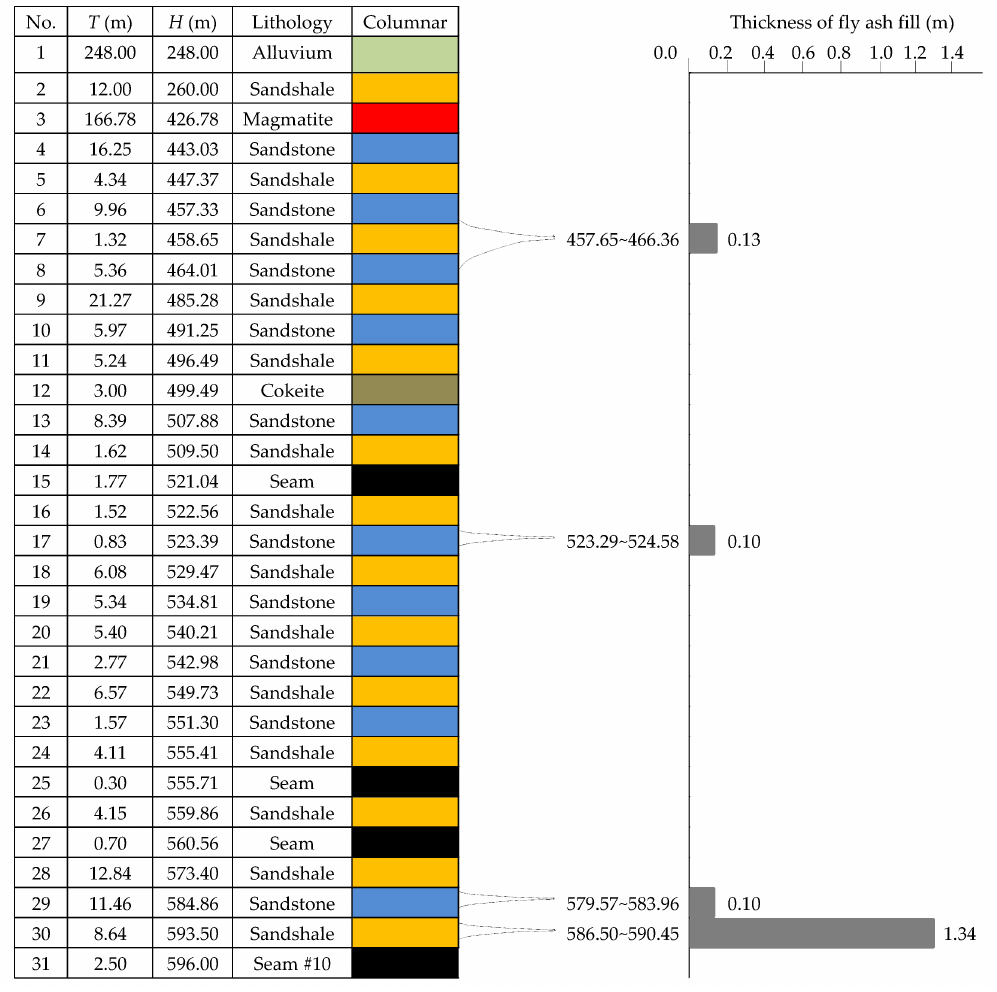
Figure 16. Columnar section and filling horizon of fly ash of drill hole D1. T is the thickness of each stratum. H is the distance from each stratum to